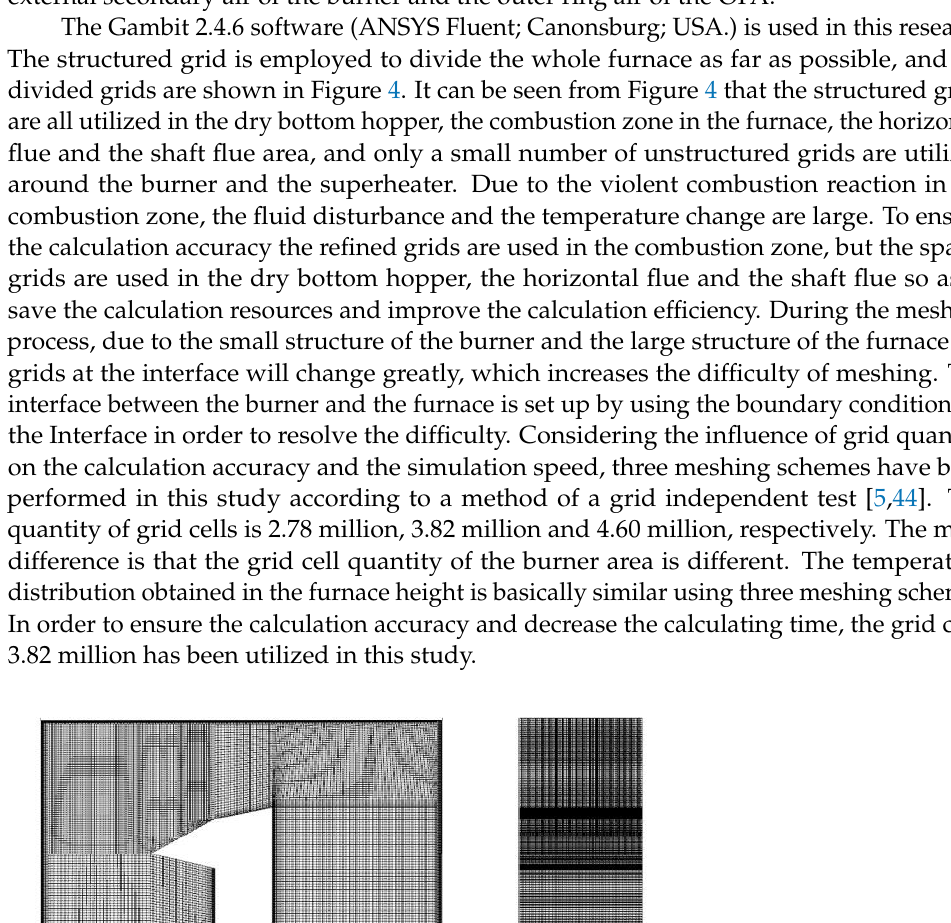
Table 1. Main operating parameters of the base operation condition (BMCR: 600 MW).